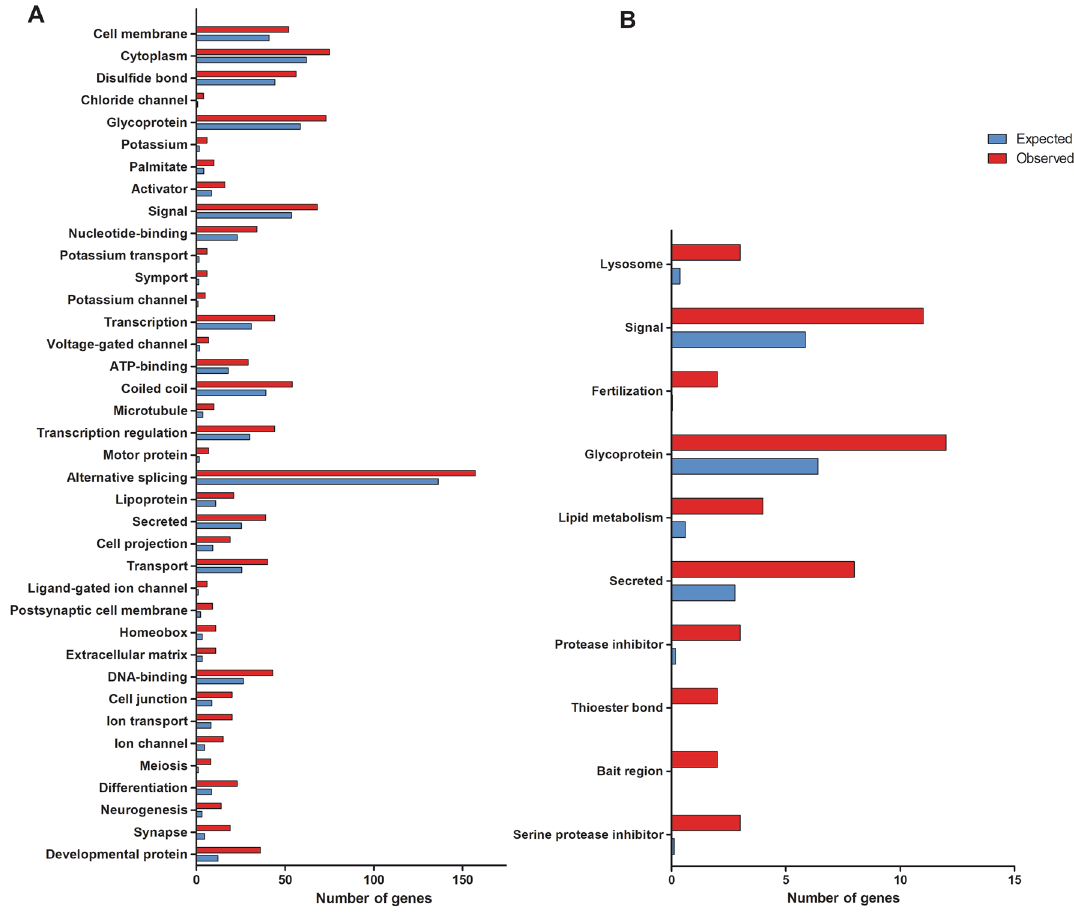
Figure 3. Enriched categories of up-regulated ( A ) and down-regulated ( B ) genes in ovaries of all hybrids. Blue indicating the number of expected genes given the gene selection would be random, red indicating the number of observed genes in the respective gene set. Significance of GO-terms is decreasing from bottom to top. Regulated is defined as p value ≤ 0.05 and log2FC ≤ ±